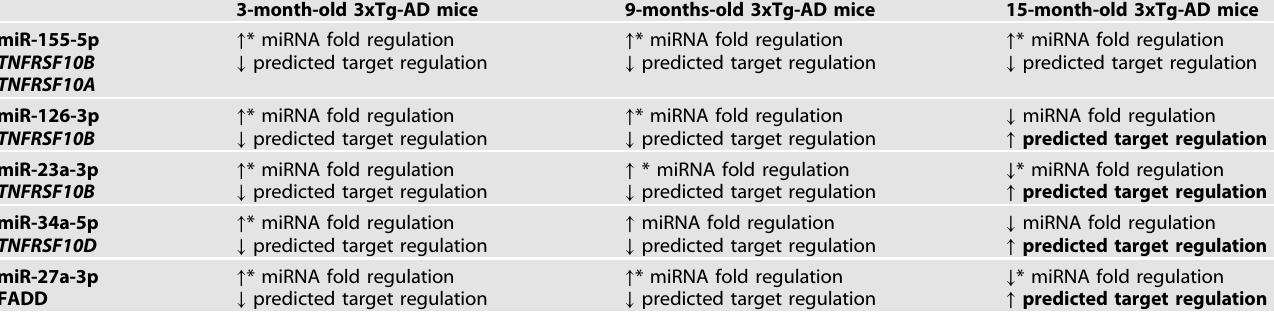
Table 1. miRNAs-TNFSF10 signaling pathways interactions in retina of 3xTg-AD mice.